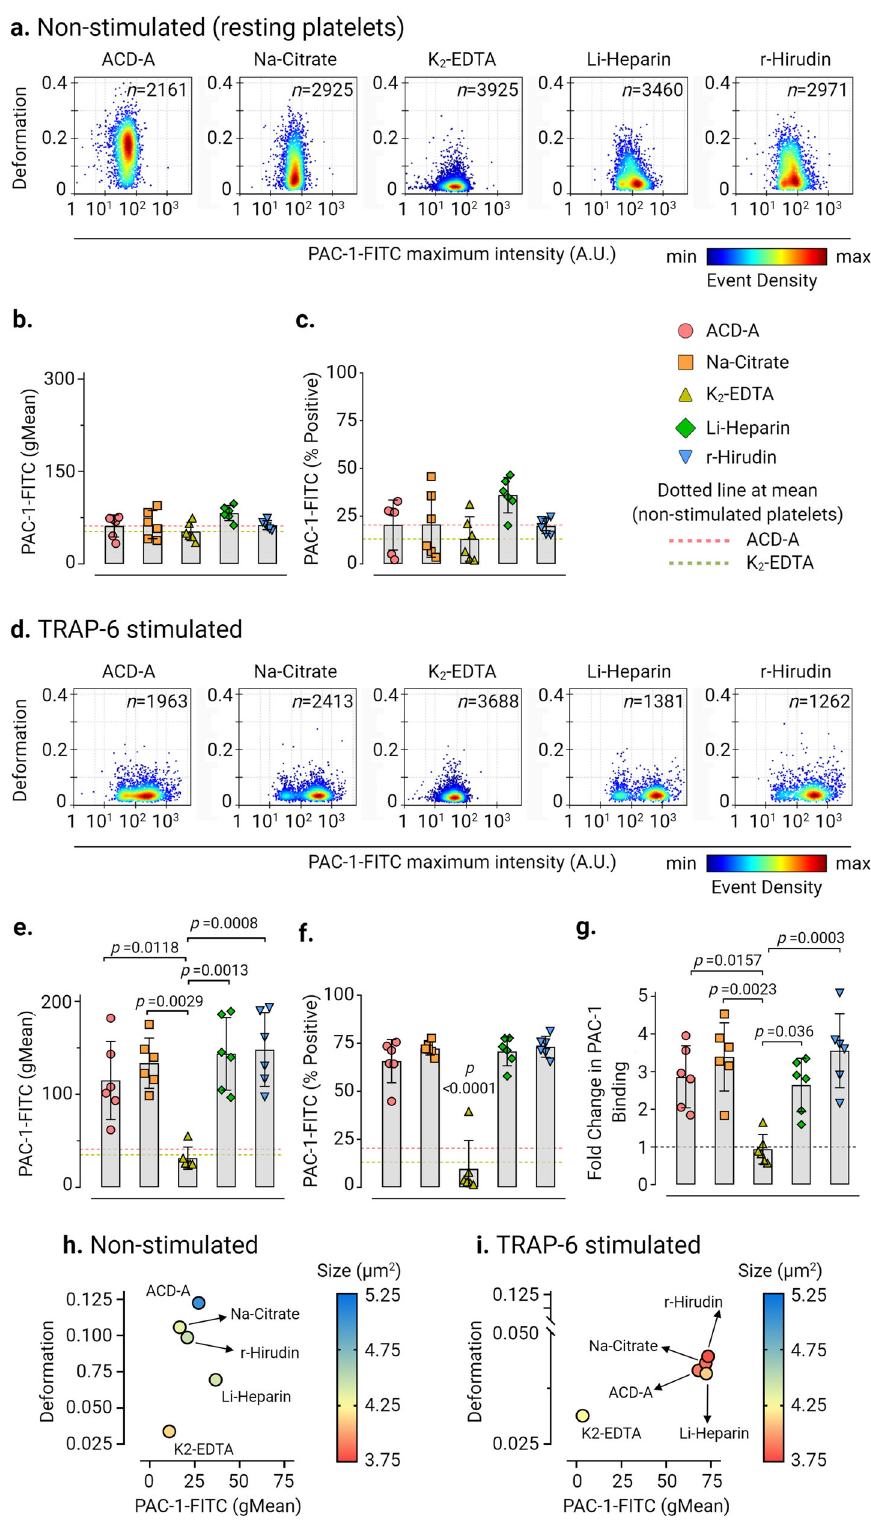
single platelets), but intriguingly their size increased (6.585 µm 2 , median n = 1112 single platelets). In contrast, the platelets from the healthy individual showed decreased deformation (0.0455, median n = 720 single platelets) and size (2.595 µm 2 ) (Fig. 7b and Supple- mentary Fig. 10b). On the other hand, in K 2 -EDTA, non-stimulated healthy control platelets showed ≈ 3-fold decreased deformation (0.036, median n = 1960 single platelets) and while MYH9